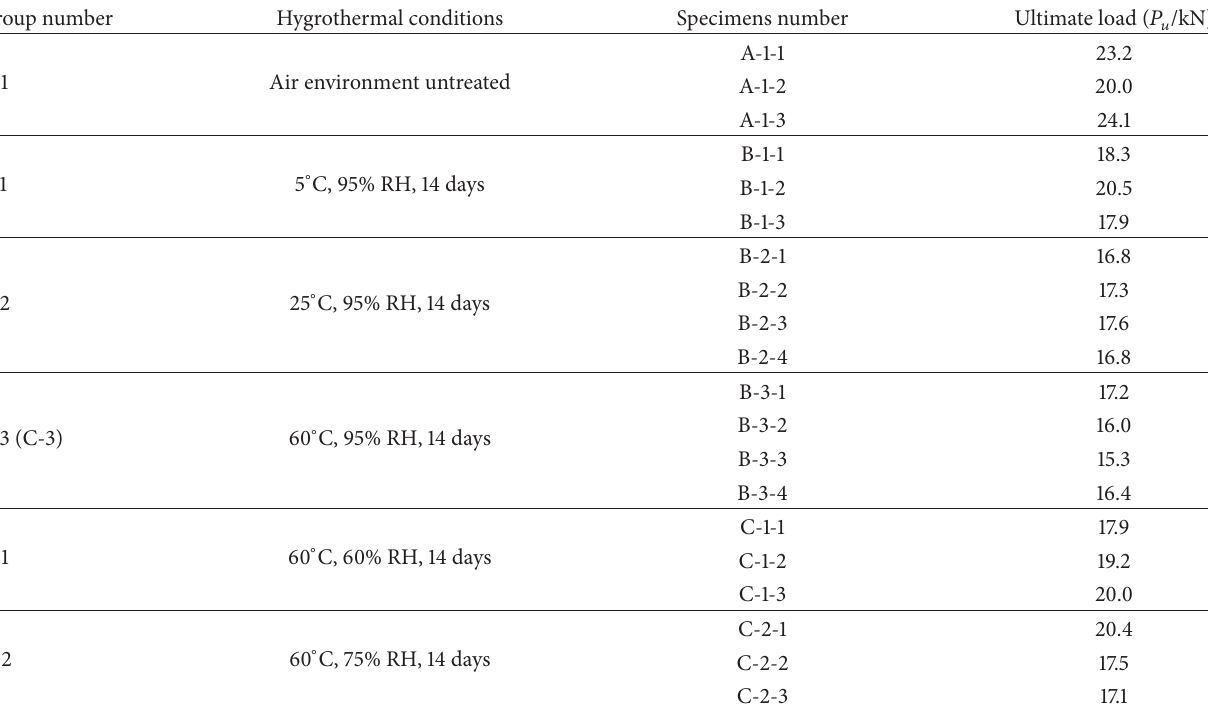
Table 2: Details of the double shear tests.